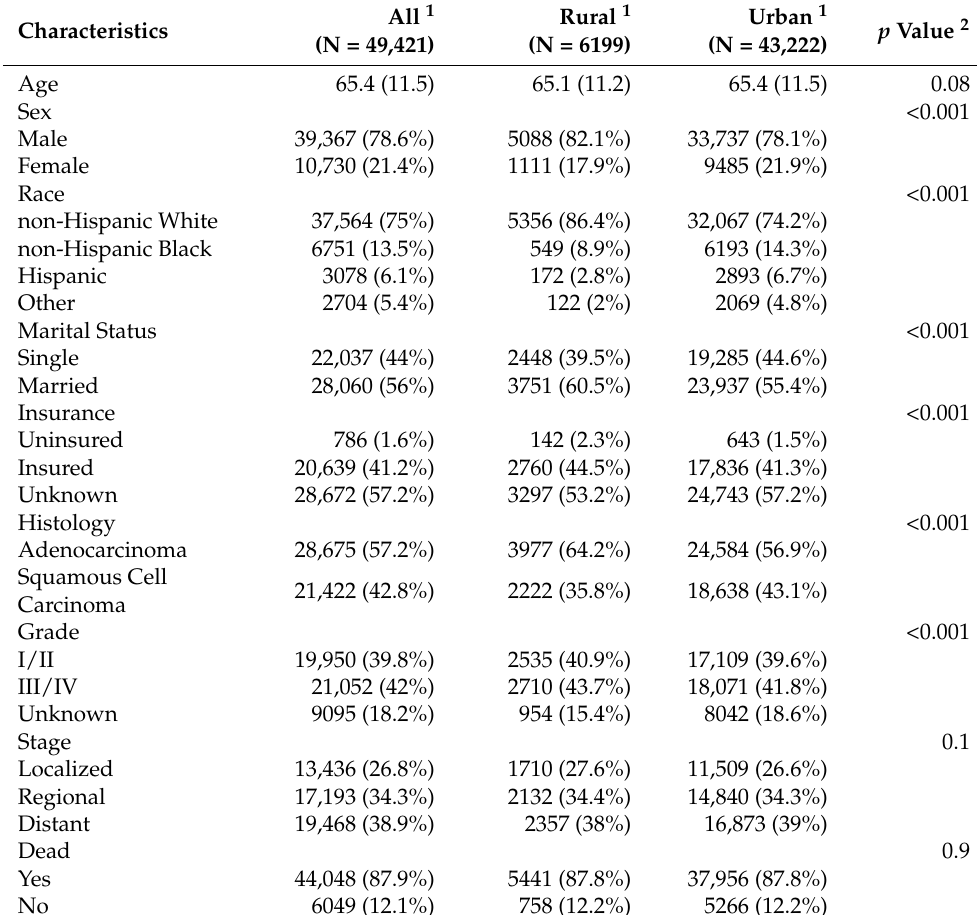
Table 1. SEER Database cohort descriptive